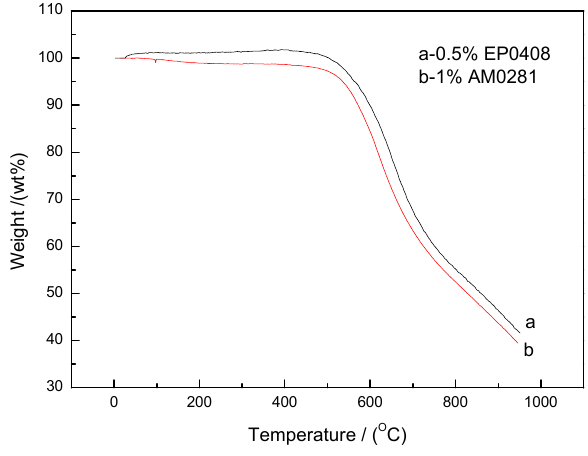
Figure 6. Comparison of the thermal stabilities of the EP0408- and AM0281-containing polymers.